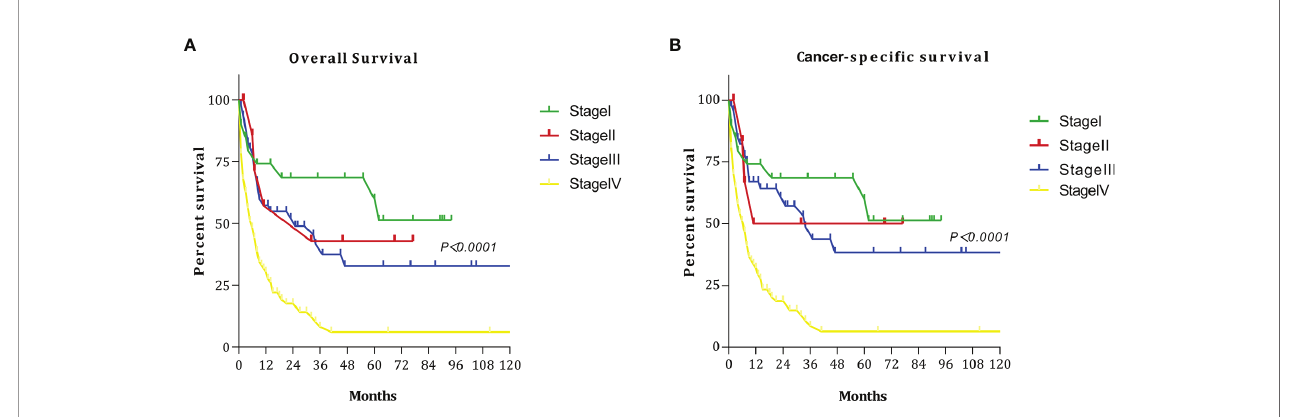
FIGURE 1 | Survival curves at each stage: (A) overall survival (OS); (B) cancer-speci fi c survival (CSS).